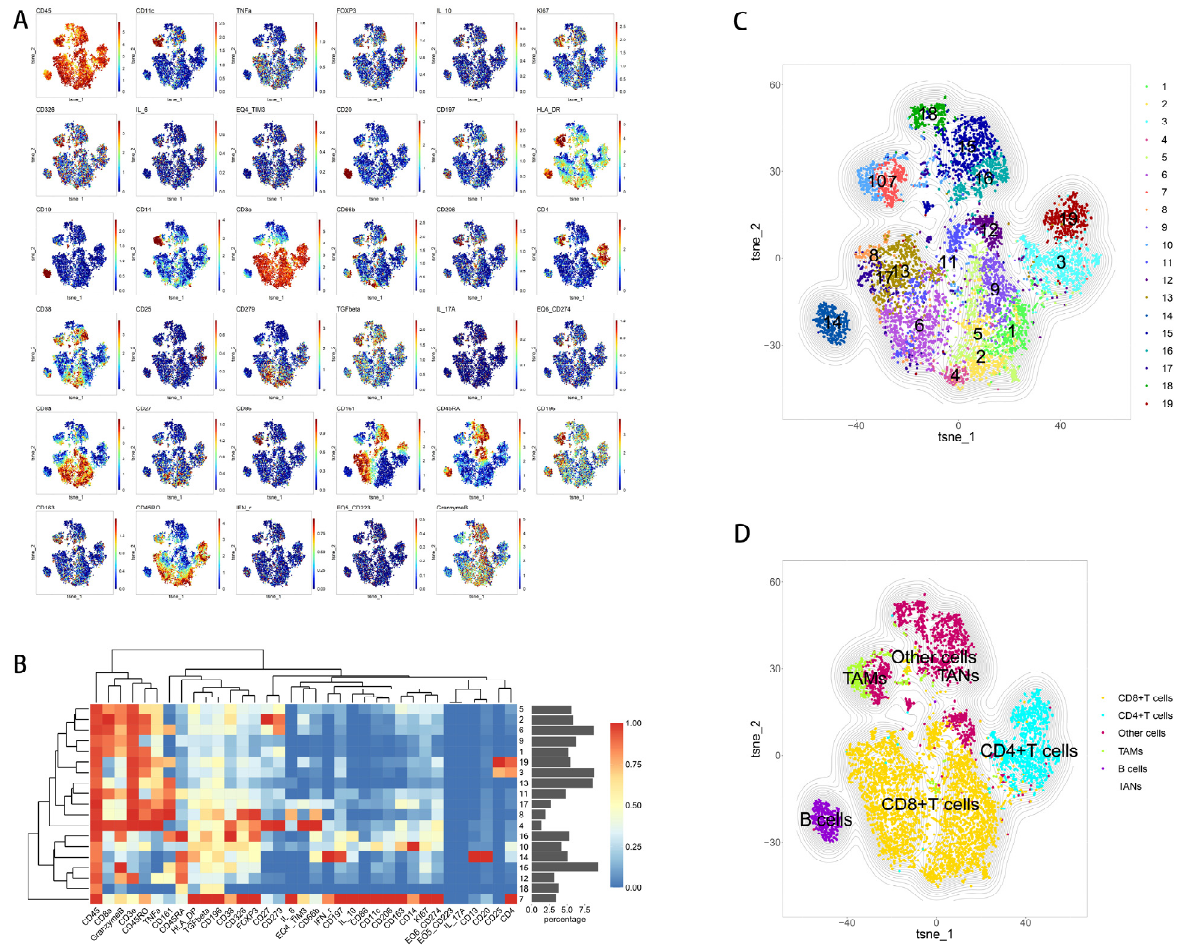
Figure 8. ( A ) t-SNE diagram of the expression of each immune marker. ( B ) Heatmap of the expression of all immune-related markers after normalization. ( C , D ) t-SNE plots of immune cells that infiltrate tumor tissues.